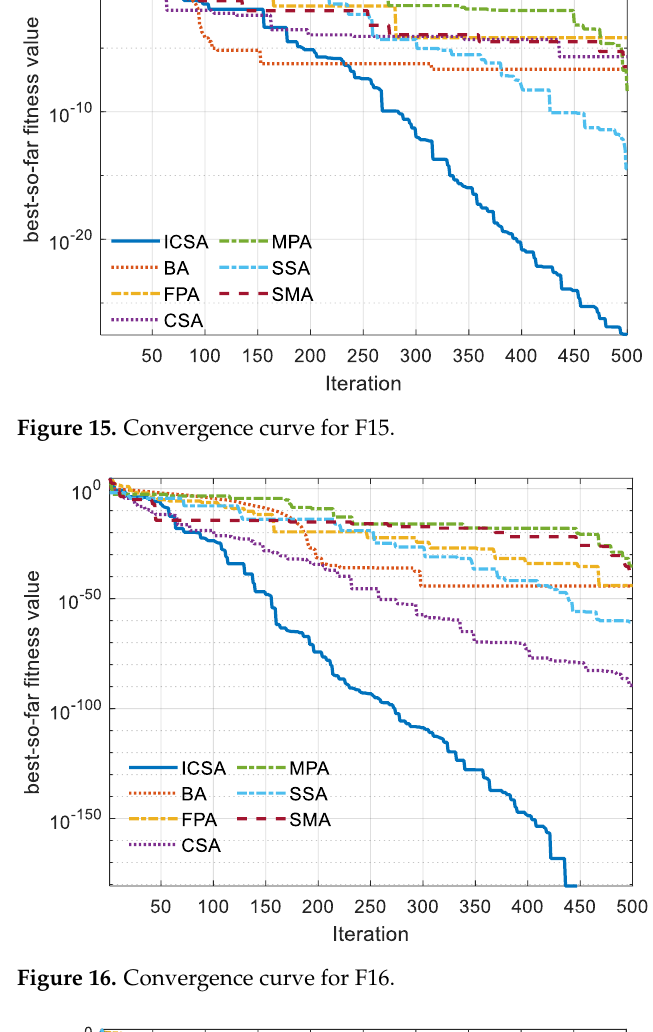
17 of 28 Figure 13. Convergence curve for F13.